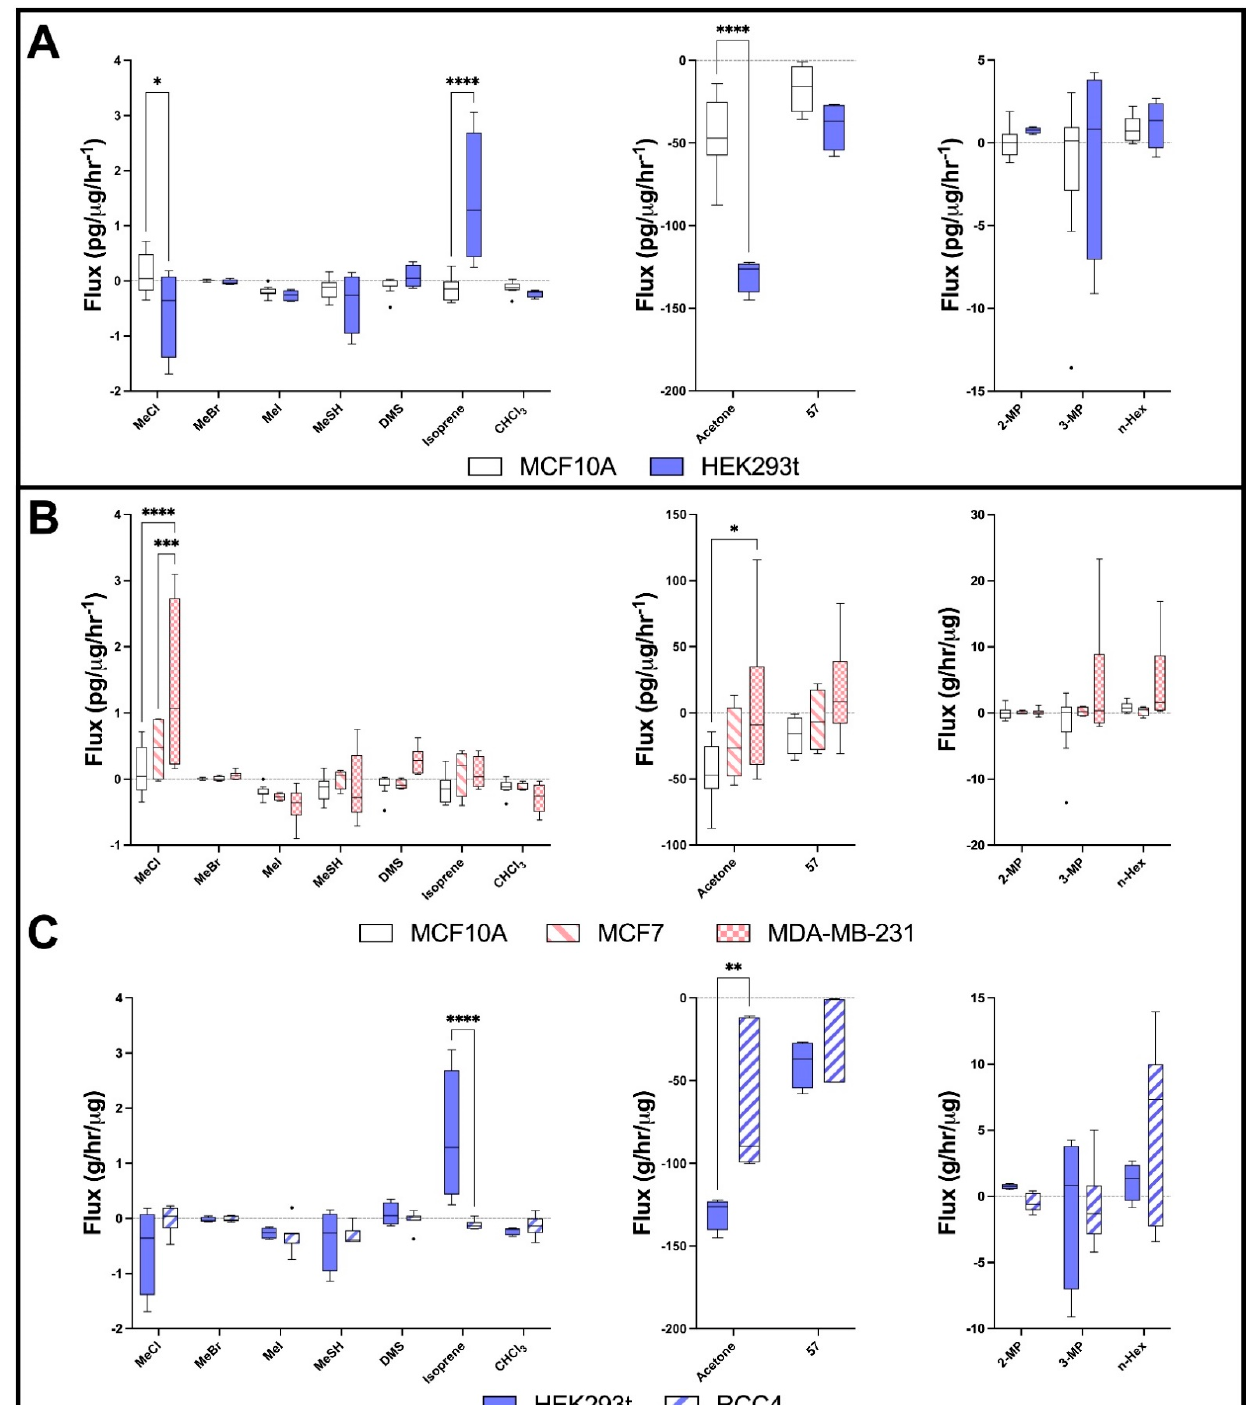
Figure 2. Cellular volatile profiles of breast- and kidney-derived cell lines. ( A ) Volatile flux (g/hr/µg) for noncancerous-derived cell lines, from breast; MCF10a and kidney; HEK293t. ( B ) Volatile flux for cancerous-breast-derived cell lines, MCF7 and MDA-MB-231. ( C ) Volatile flux for cancerous-kidney-derived cell line RCC4. Media subtracted and protein-normalised VOC flux for MCF10a ( n = 9); MCF7 ( n = 4); MDA-MB-231 cells ( n = 6). CHCI3 = Chloroform, DMS = Dimethyl sulphide, MeBr = Methyl bromide, MeCl = Methyl Chloride, MeI = Methyl iodide, MeSH = Methanoethiol. Boxplot whiskers show median ± Tukey distribution. ANOVA followed by Bonferroni post hoc test was performed; * p < 0.05; ** p < 0.01; *** p < 0.001; **** p <